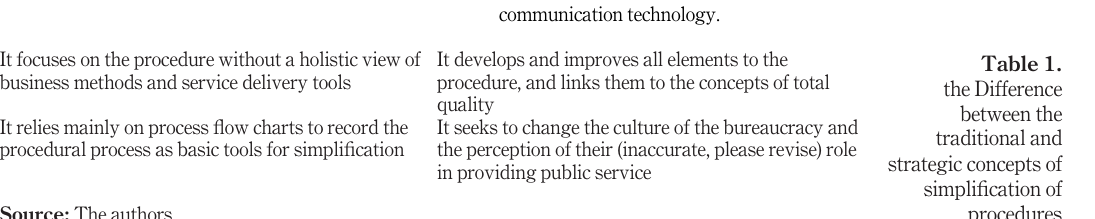
Table 1. the Difference between the traditional and strategic concepts of simpli fi cation of